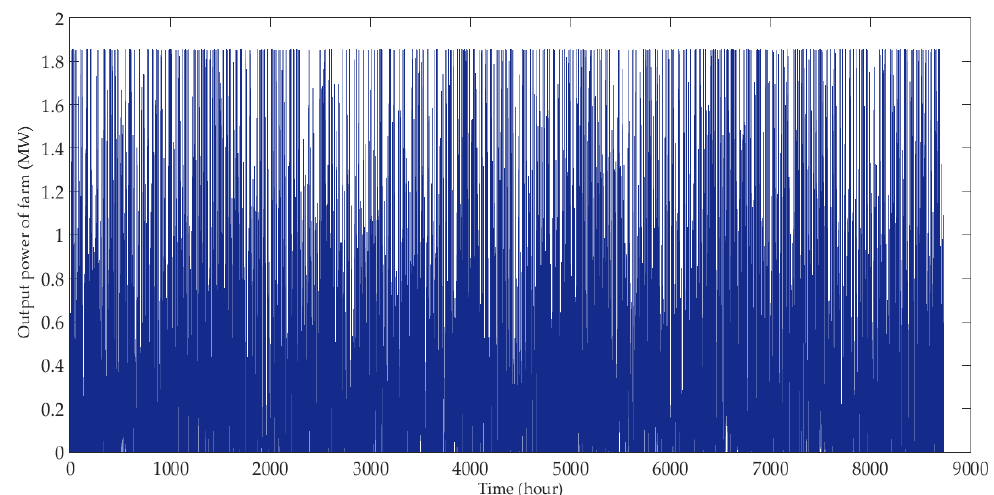
Figure 9. Simulation of the output power from wind farm for the sampling year.